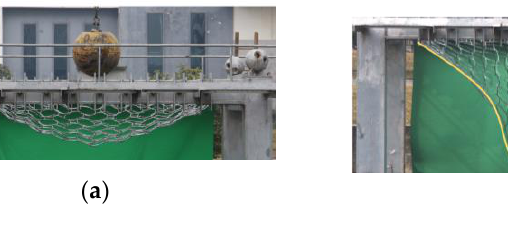
Figure 8. Force displacement curves of the ring net with different specifications. Table 4. Breaking force and breaking displacement of ring nets with different specifications under a dynamic impact condition. Specifications